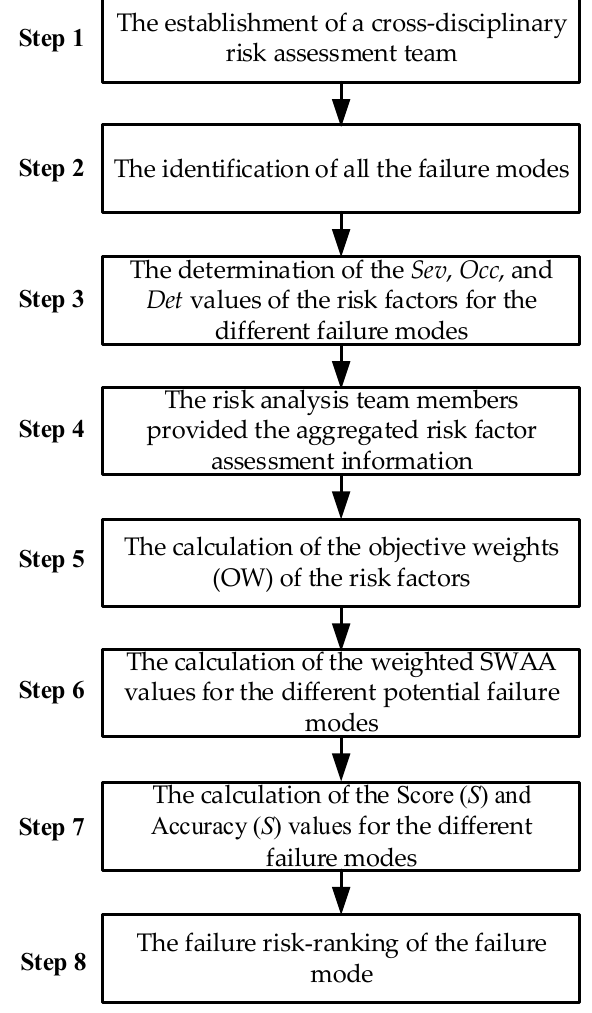
Figure 1. The fl owchart of the proposed